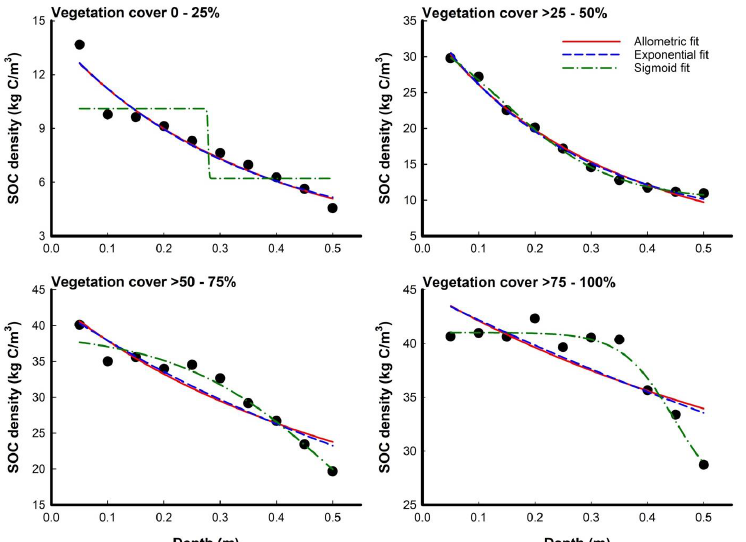
functions (allometric, exponential, and sigmoid) are presented in Figures 3 and 4, while the density and cumulative SOC stock, respectively.